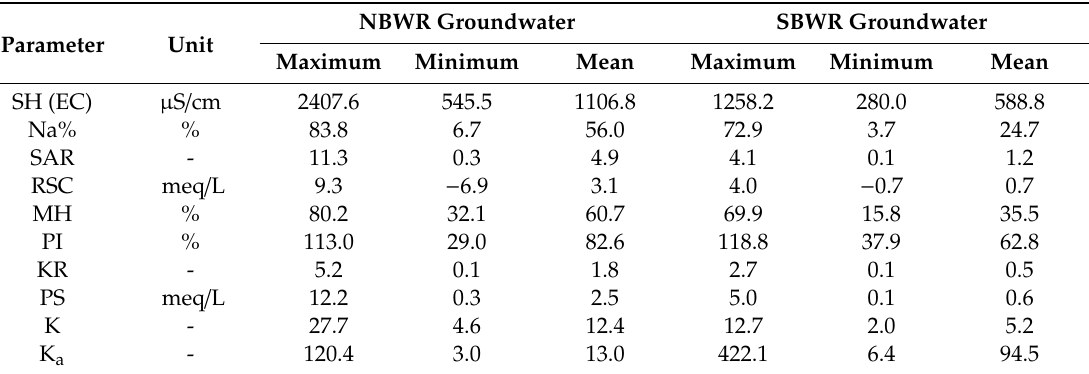
Table 2. Water-quality parameters for